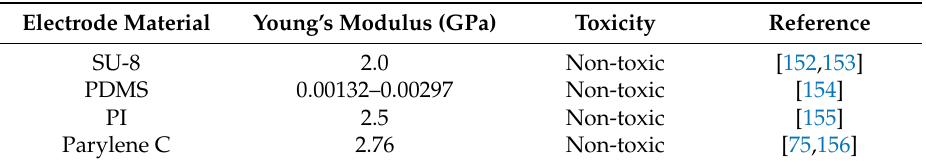
Table 1. Properties of substrate